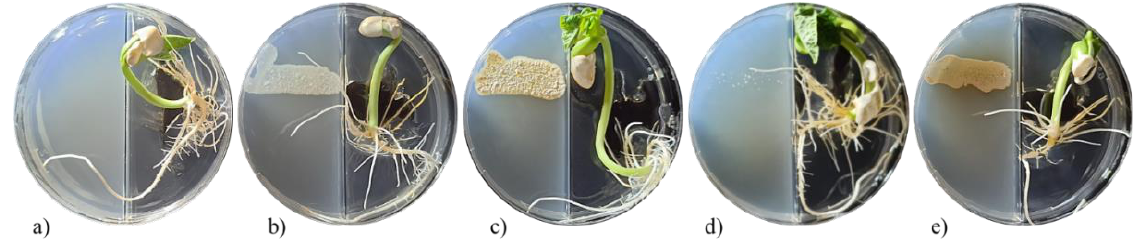
Figure 3. Appearance of P . vulgaris seedlings after exposure for 5 days to VOCs emitted by Strepto- myces strains. The assay was performed using divided Petri dishes; P . vulgaris seeds were sown on the right, and Streptomyces strains on the left of the dishes: ( a ) control; ( b ) S . cangkringensis CIAD – CA07; ( c ) S . misionensis CIAD – CA27; ( d ) S. kanamyceticus CIAD – CA45; and ( e ) S. kanamyceticus CIAD – CA48.